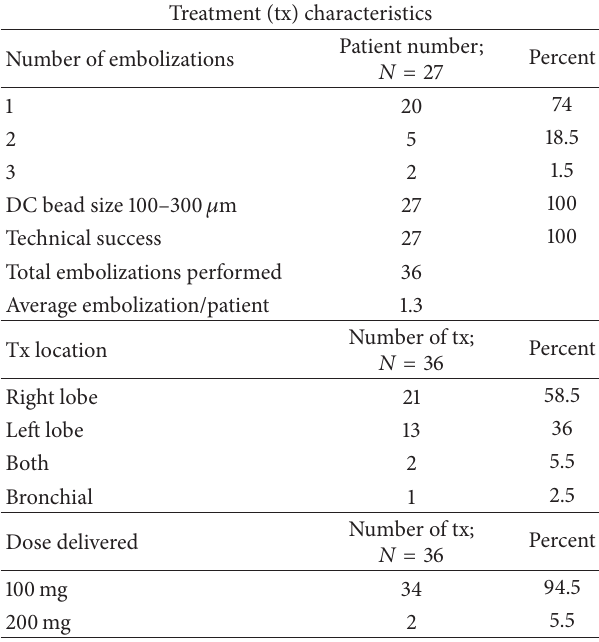
Table 1: Patient characteristics. Table 2: Characteristics of treatment